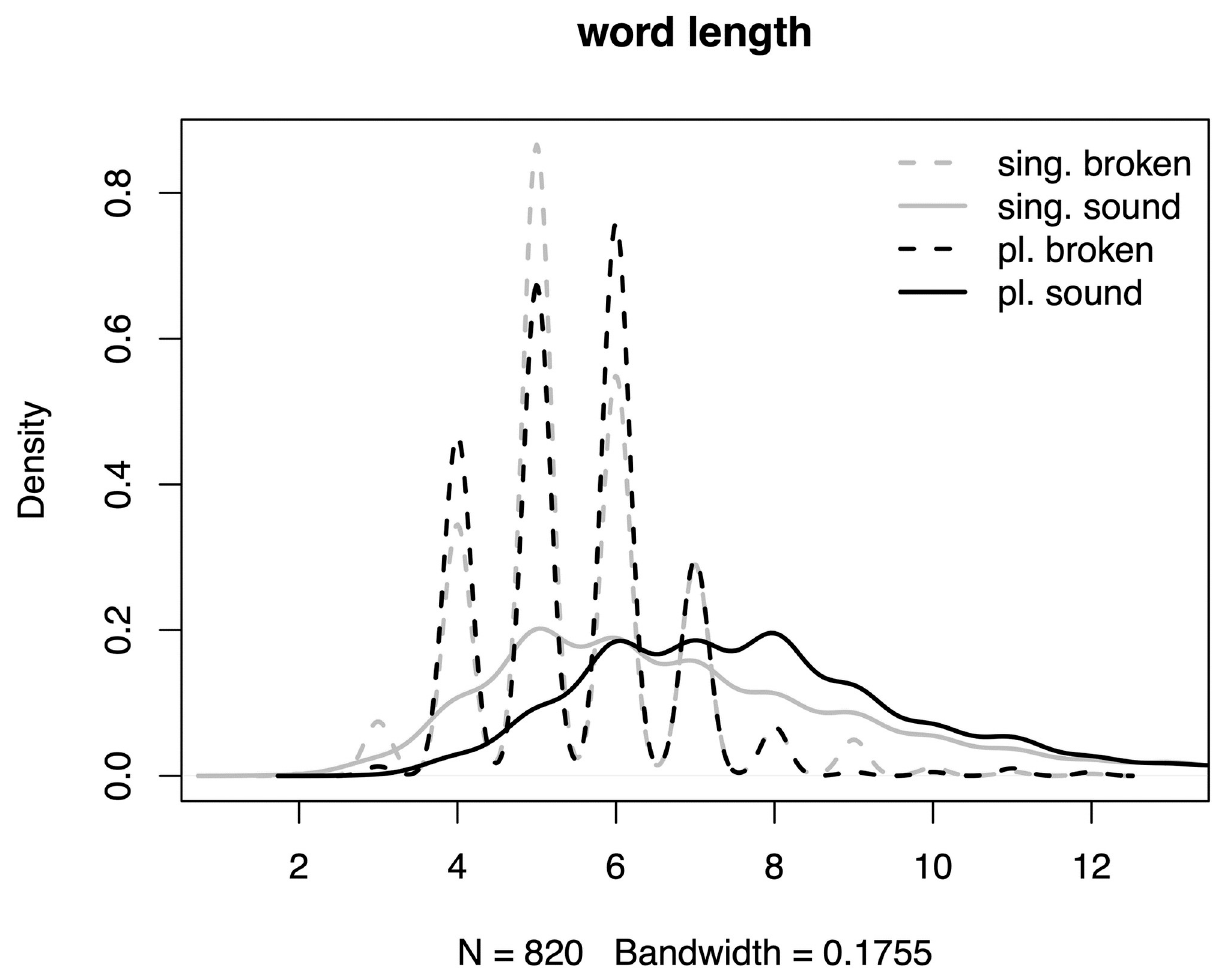
Fig 2. Density plots of word length in the Maltese